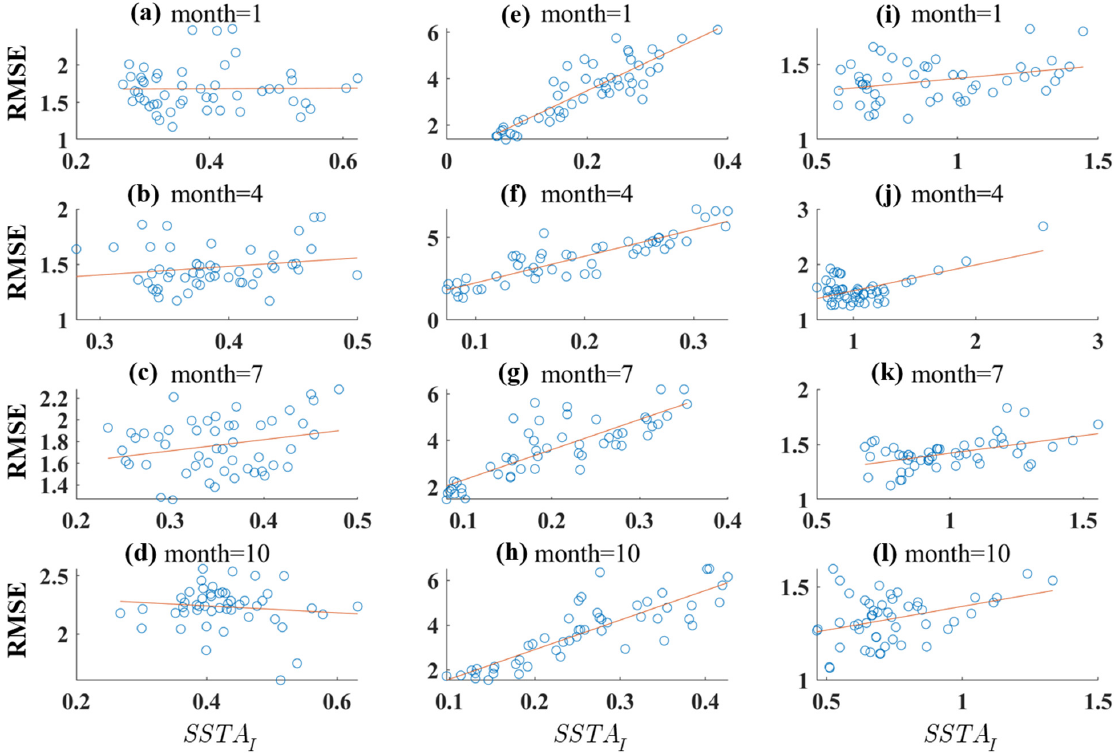
Figure 6. The relationship between SSTA I ( ◦ C) and RMSE (m/s) in Areas A ( a – d ), B ( e – h ), and C ( i – l ) in January, April, July, and October. The blue circles denote the scattered RMSE points in grids. ((cid:2869)) and 𝑝 ((cid:2869)) in Areas A, B, and C are all recorded in To facilitate the observation, 𝑝 (cid:3020)(cid:3013)(cid:3002) (cid:3020)(cid:3020)(cid:3021)(cid:3002) Table 1, with the superscript A, B, and C representing Areas A, B, and C, respectively. Through the comparison of the SLA and SSTA sensitivity ( 𝑝 ((cid:2869)) ) among Areas A, B, and C, it can be found that the 𝑆𝐿𝐴 (cid:3010) and 𝑆𝑆𝑇𝐴 (cid:3010) both contribute to the RMSE, with the 𝑆𝐿𝐴 (cid:3010) be- ing the more important in fl uential factor. The enhancement of the 𝑆𝐿𝐴 (cid:3010) and 𝑆𝑆𝑇𝐴 (cid:3010) will lead to a clearer linear relationship between the sea surface parameters and RMSE. On the contrary, the decrease in the 𝑆𝐿𝐴 (cid:3010) and 𝑆𝑆𝑇𝐴 (cid:3010) will weaken the linear relationship.